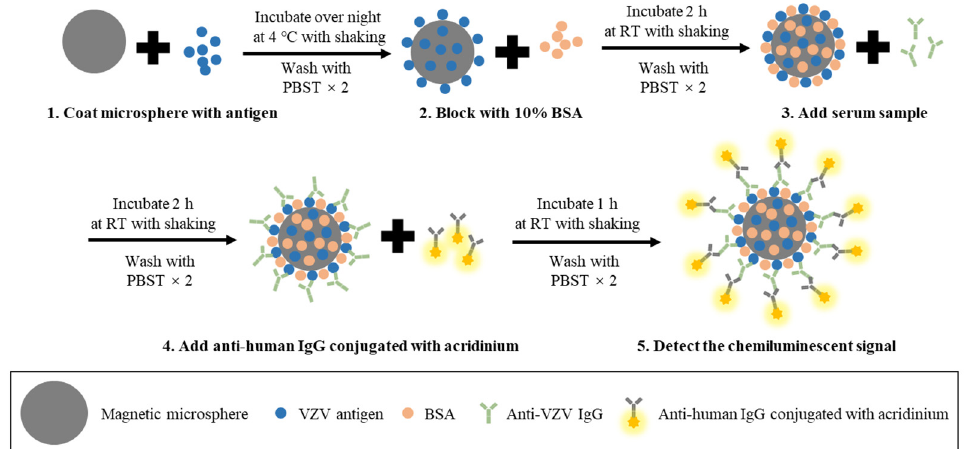
Figure 7. Schematic diagram depicting the basic steps of CLIA for the detection of anti-VZV anti- bodies. (1) Magnetic microspheres are coated with the VZV antigen (e.g., VZV gE) and incubated overnight at 4 °C with shaking. (2) After washing, microspheres are blocked with 10% BSA and incubated for 2 h at 37 ◦ C with shaking. (3) After washing, diluted serum samples are added to the coated microspheres and incubated for 2 h at 37 ◦ C with shaking. (4) After washing, anti-human IgG conjugated with acridinium is added and incubated for 1 h at room temperature (RT) with shaking. (5) After washing, the magnetic microspheres are resuspended with PBS and the chemiluminescent signal is detected with a chemical luminescence immune